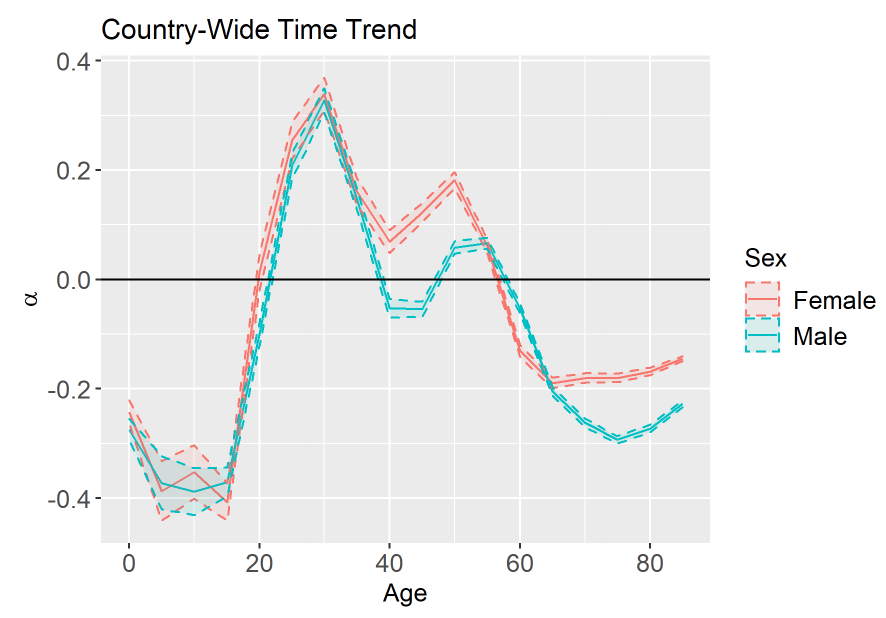
Figure 8. Estimates and 95% credible intervals for α (country-wide time trend) by age and sex.